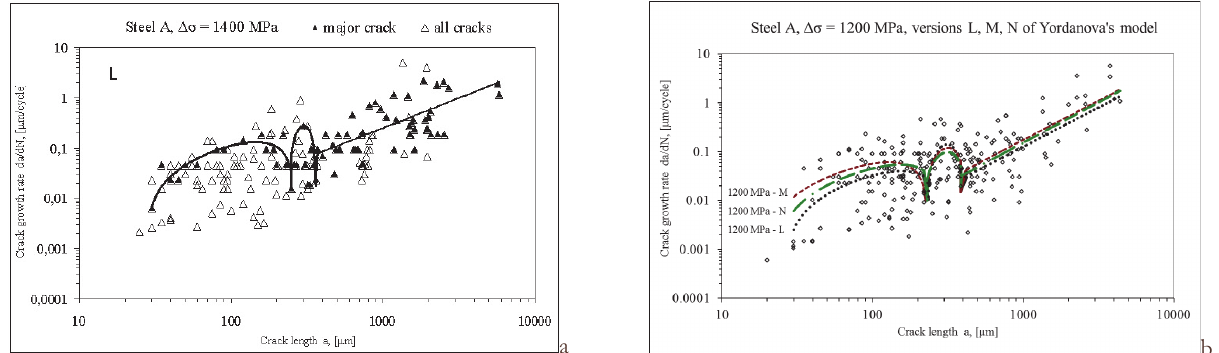
Figure 2: New Parabolic-linear model “Crack growth rate, da/dN – crack length a ” for Steel A: (a) L version, Δσ =1400 MPa;.(b) comparison between L, M and N versions, Δσ = 1200 MPa